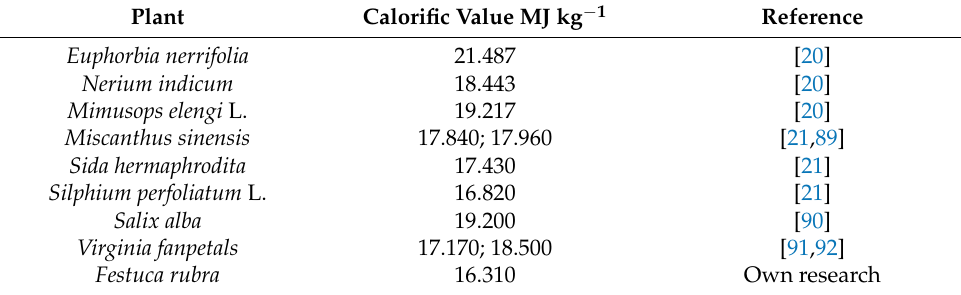
Table 7. Calorific value of various biomass